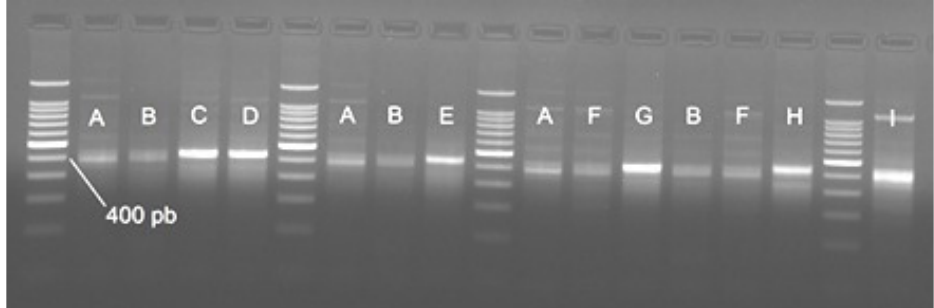
Figure 8. Band patterns given by amplifying the locus rhodopsin with universal primers. A— H. huso ;